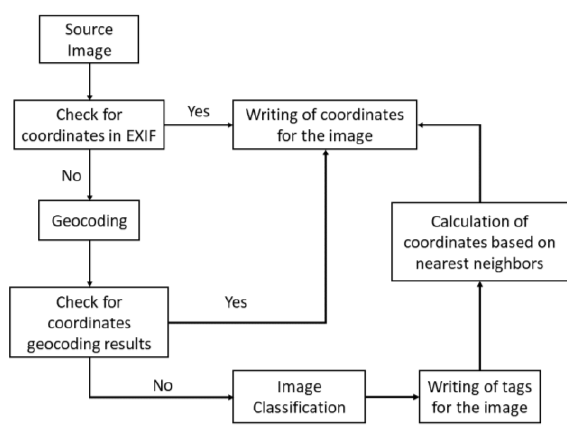
Figure 1. Photo processing